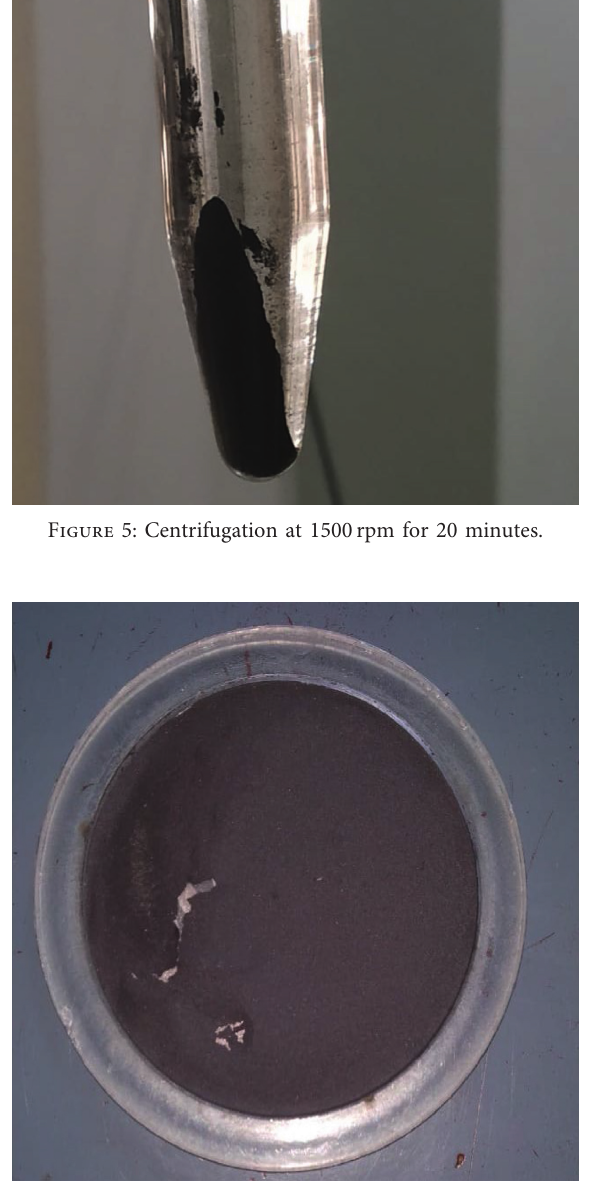
Figure 6: Dried at 120 ° C for 8 hours.